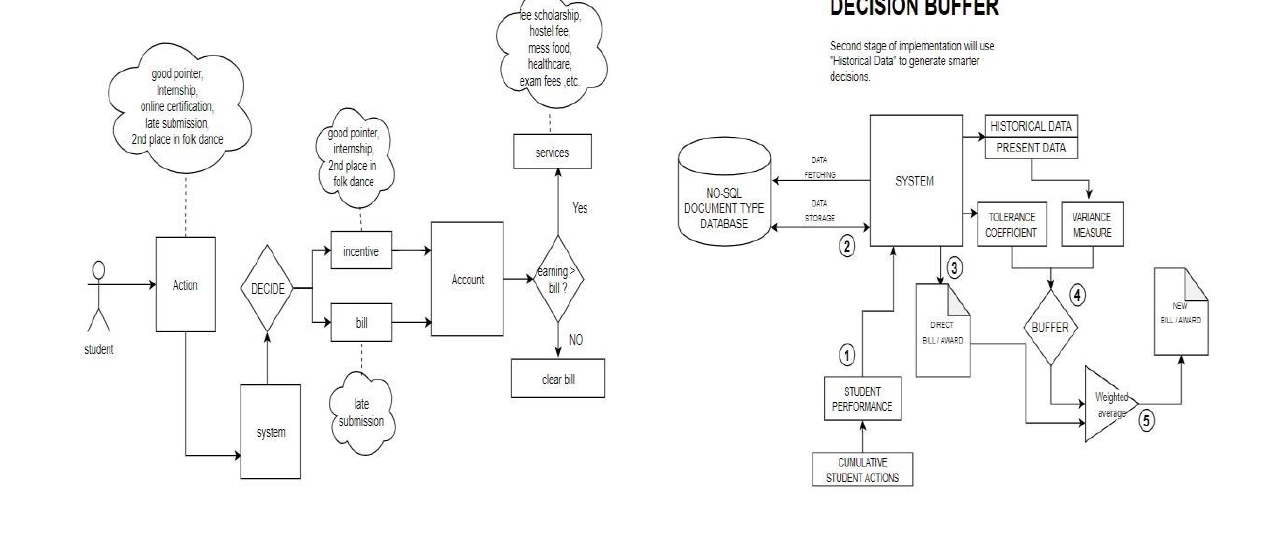
Figure 2. Overview of decision bu ff er